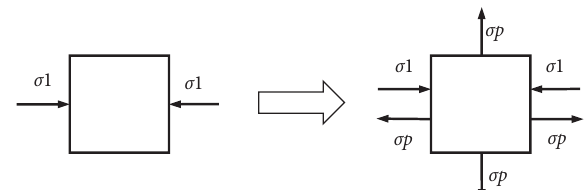
Figure 5: Te main stress change before and after the expansion of the microunit body.